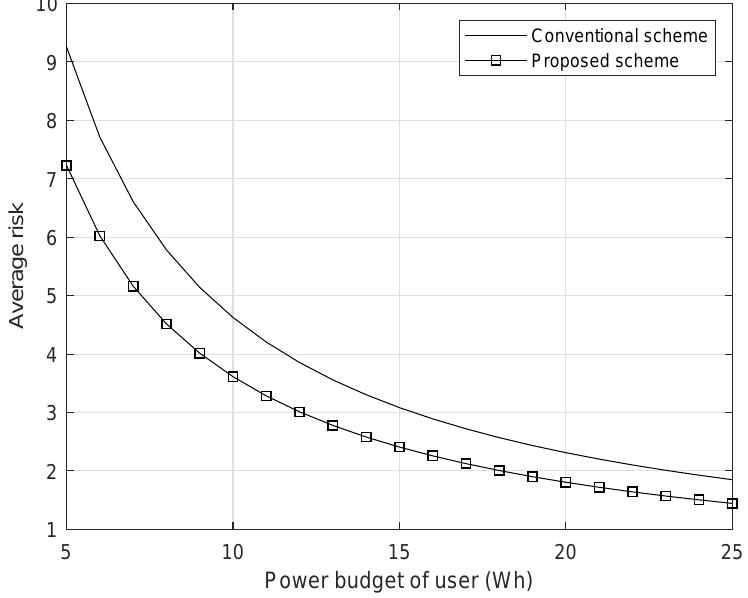
Figure 8. The average risk with respect to the power budget of the user.